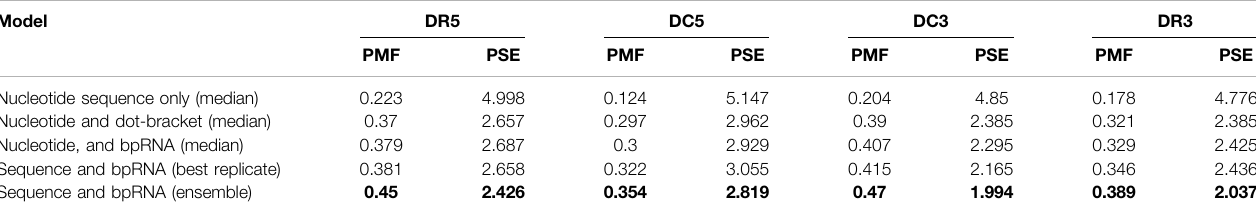
TABLE 2 | Median, best replicate, and ensemble performance metrics for each type of cut site and input. The best performance for each column is indicate in bold, i.e. highest PMF or lowest PSE. Model